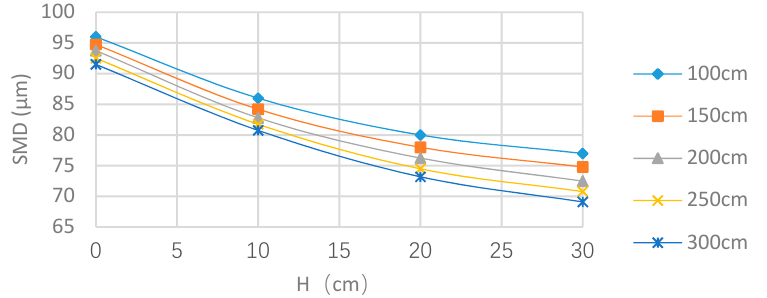
Figure 9. The radial distribution of droplets’ diameter.